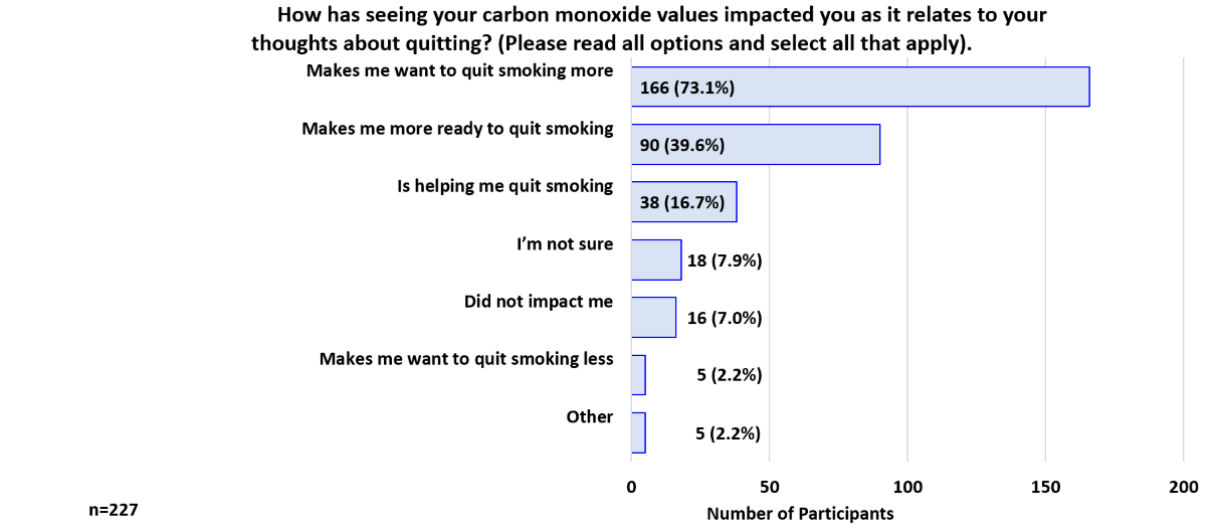
Figure 8. Participant Feedback: Impact of carbon monoxide values on thoughts about quitting (week 1).